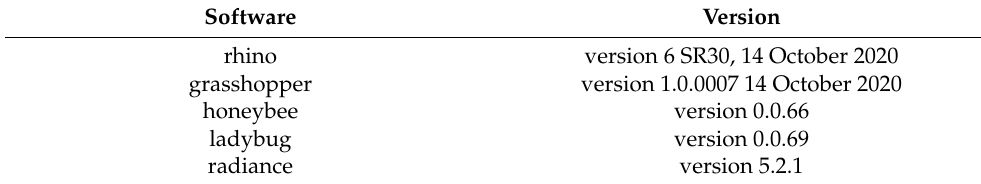
Table 3. Software list.